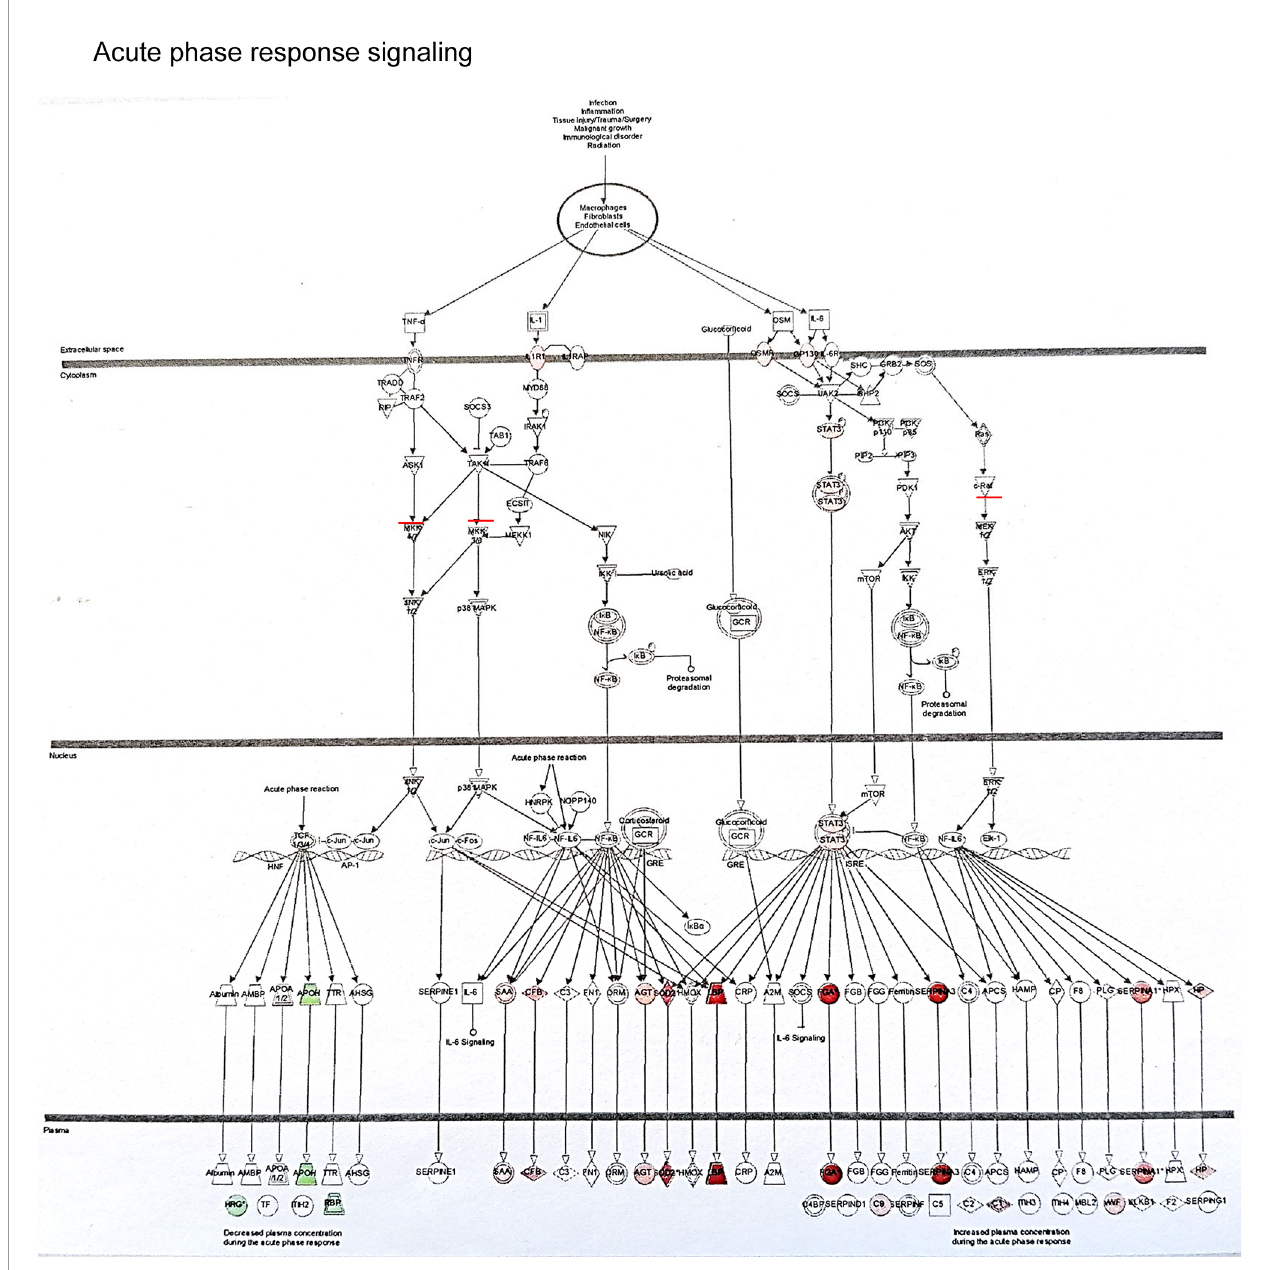
FIGURE 7 | This schematic picture illustrated an example of acute phase response signaling pathways in the different compartment of cells such as the nucleus, cytoplasm and extra cellular space produced by Ingenuity Pathway Analysis, with red or green color highlighted up or down-regulated